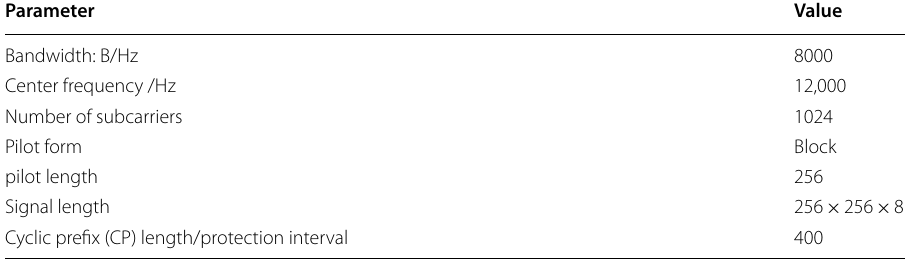
Table 1 S imulation parameters of the OFDM packet Parameter